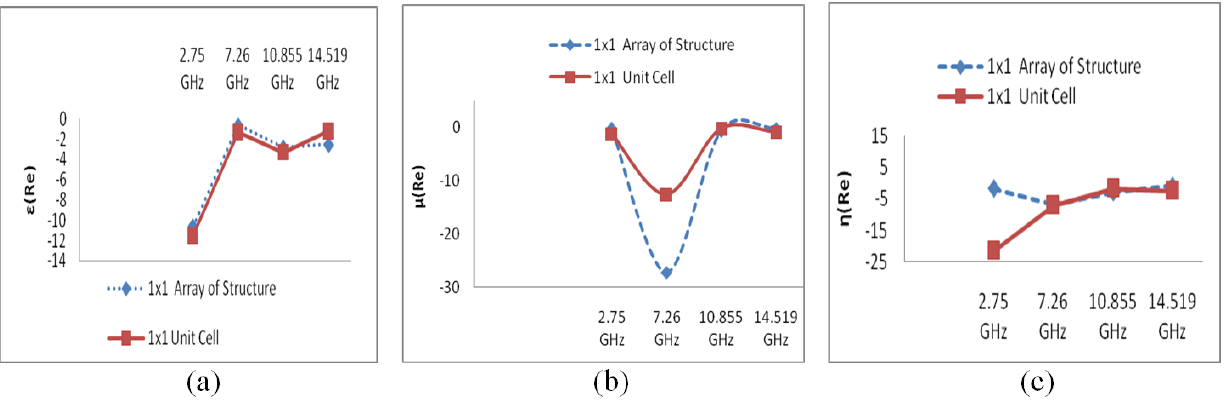
Figure 18. ( a ) ε-value comparison of 1 × 1 configurations; ( b ) µ-value comparison of 1 × 1 configurations; ( c ) η-value comparison of 1 × 1